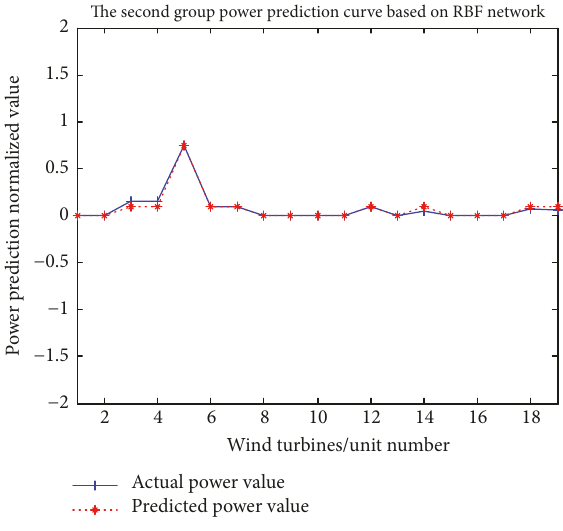
Figure 7: The second group power forecast curve.